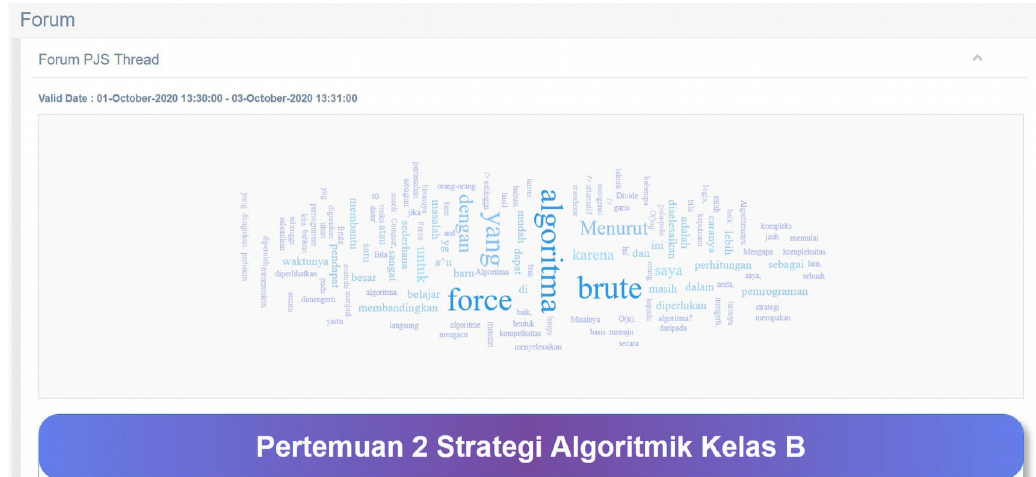
Figure 3. An example of interactions in a discussion forum and important issues are represented as word